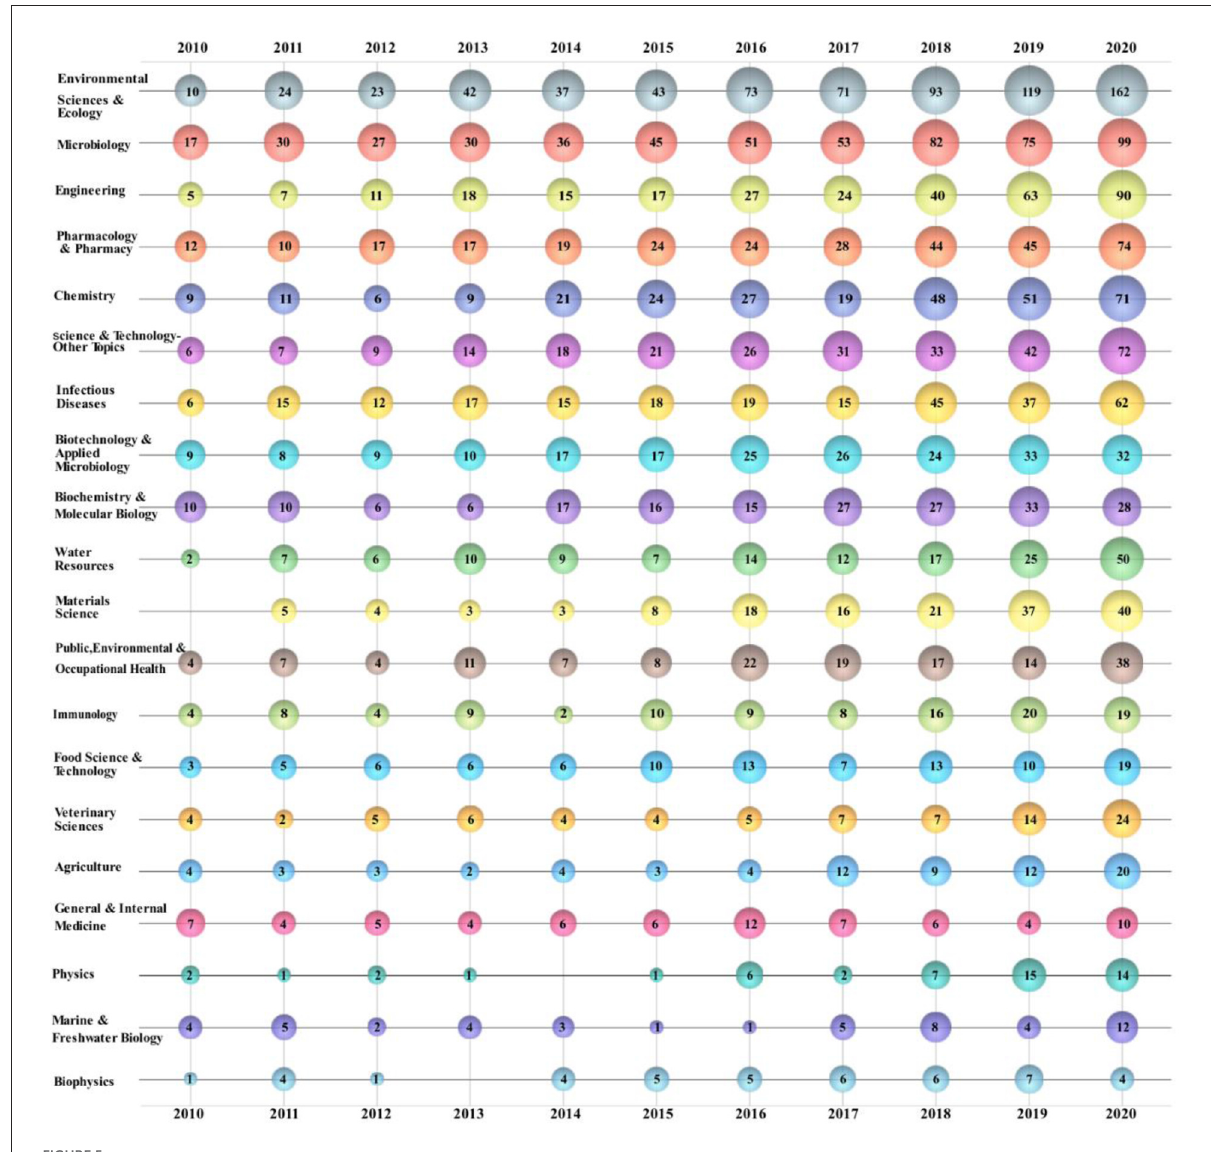
FIGURE5 Bubble chart of top 20 ARB research